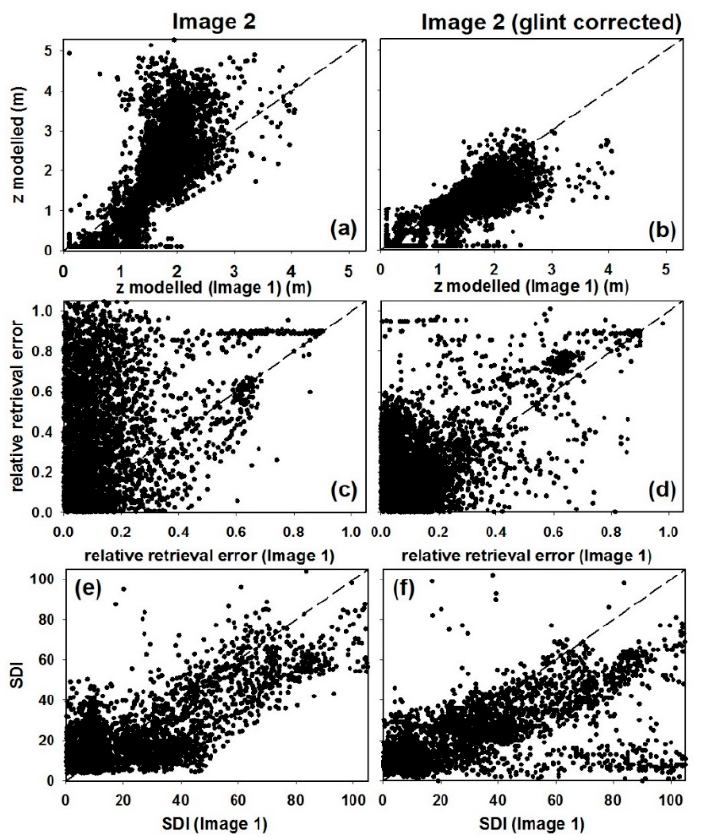
Figure 7. Relative comparison of depth retrieval: scatterplot of the model-estimated depth retrieved from Image 1 versus model–estimated depth retrieved from ( a ) Image 2 and ( b ) Image 2 after glint correction (dashed line represents 1:1 relationship). Scatterplot of absolute relative depth errors ( |p measured z ´ modeled z q|{ measured z ), retrieved from Image 1 versus absolute relative depth errors retrieved from ( c ) Image 2 and ( d ) Image 2 after glint correction. Scatterplot of SDI retrieved from Image 1 versus SDI retrieved from ( e ) Image 2 and ( f ) Image 2 after glint correction.